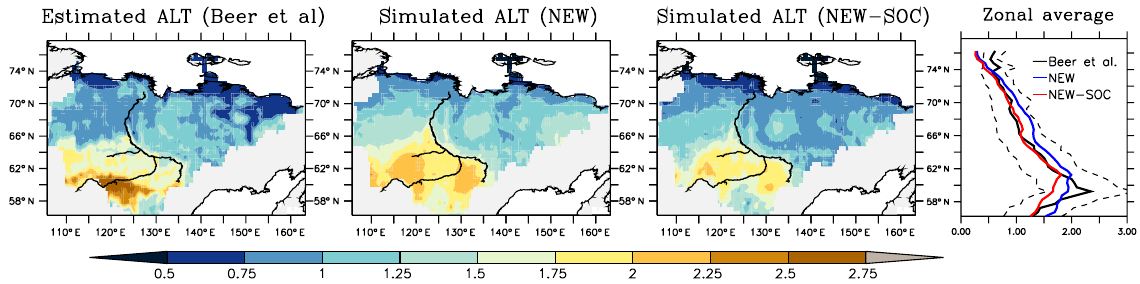
Figure 13. Estimated and simulated active layer thicknesses over the Yakutia region. Estimations before the 1990s are given by Beer et al. (2013), while the NEW and the NEW-SOC experiments are averaged over the 1979–1990 period. The estimated and simulated latitudinal zonal averages are shown in the last panel where Beer et al. (2013) estimations are in black, NEW in blue, and NEW-SOC in red. Dashed lines correspond to uncertainties in active layer thicknesses estimations computed using standard deviations provided by the data